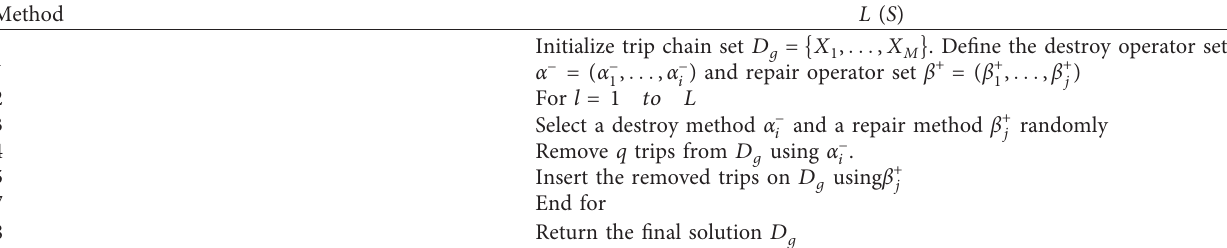
Table 5: Framework and steps of method L ( S